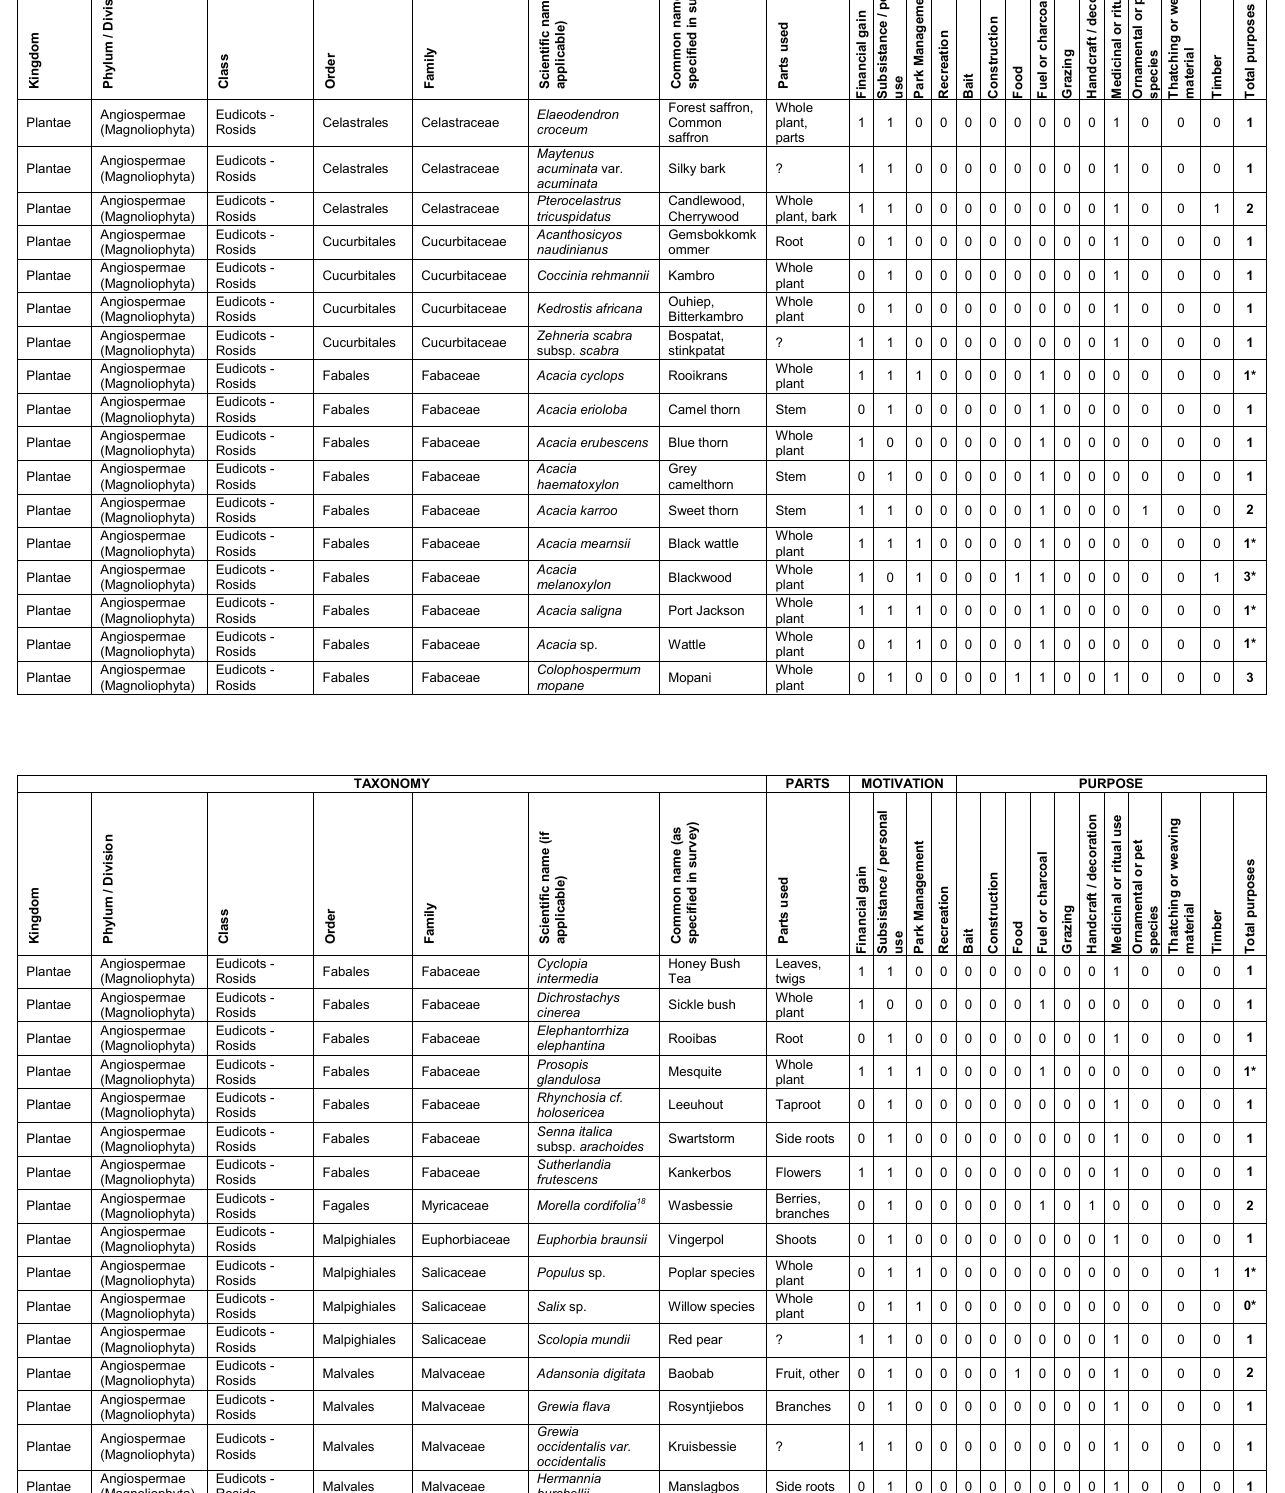
Willow species Whole plant Grewia occidentalis var. occidentalis